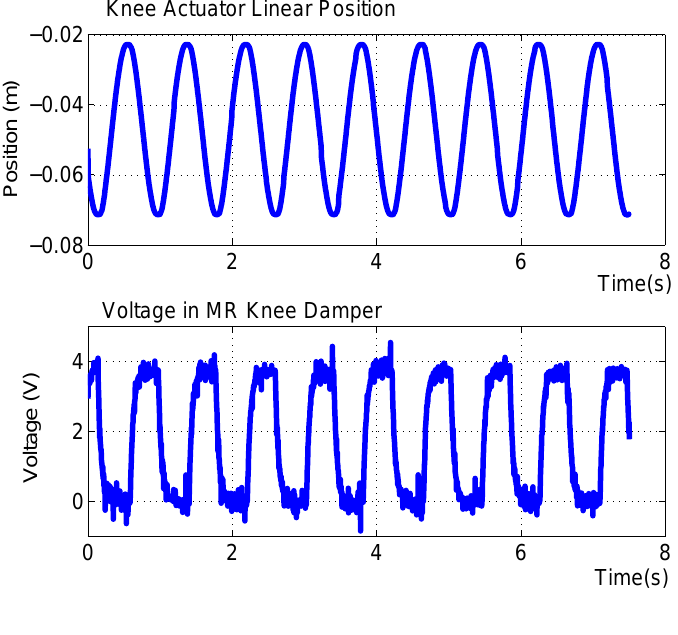
Figure 26. Experimental trajectories of the knee actuator and power consumption of the knee MRF damper during cyclic flexion-extension motions of the leg in support carrying a 12-kg payload.